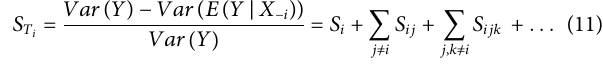
epistemic combinations results in a value of one or